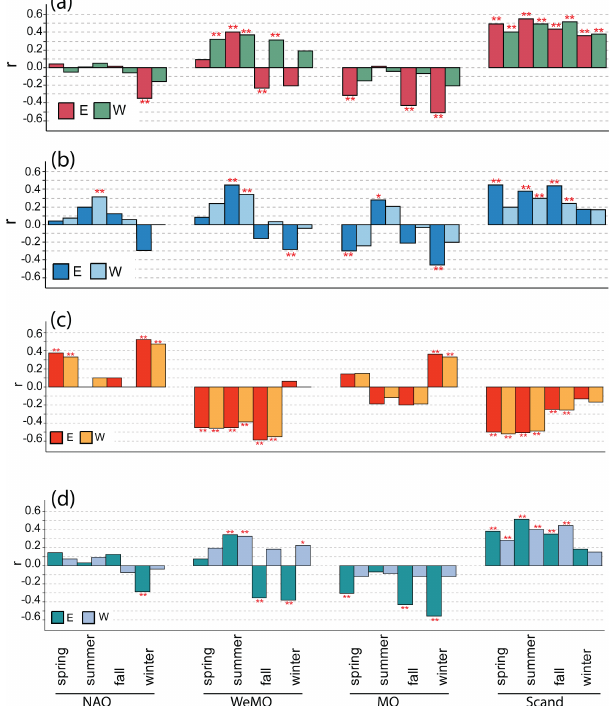
Figure 3. Estimated correlations between the teleconnection pat- terns and (a) RDI03, (b) water discharge, (c) temperature, and (d) precipitation. For (a) , (c) , and and (d) the period considered is 1959–2018, whereas in (b) the period considered is 1976–2018. Water discharge for each cluster is the sum of each river’s water dis- charge whose watershed belongs to either one of the cluster. Thus, western discharge is the sum of the Aude, Agly, and Tet water dis- charge, and eastern discharge the sum of Herault, Orb, and Tech water